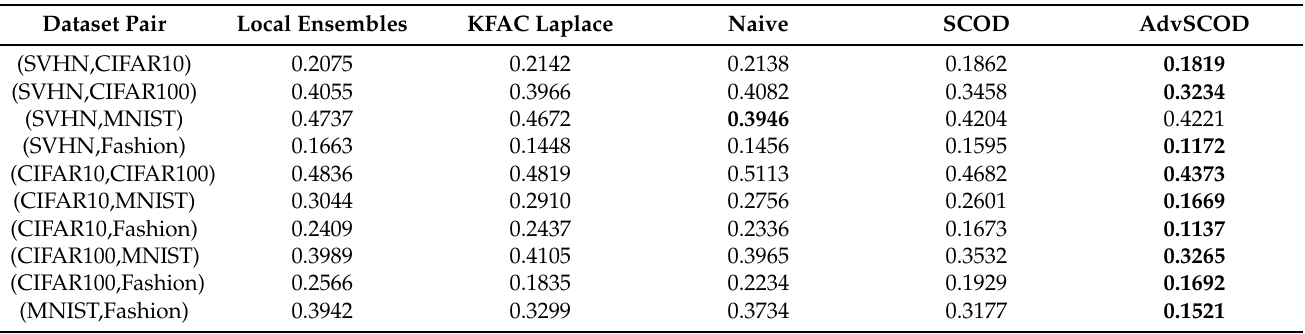
Table 4. Comparison of the OOD detection performance measured by FPR95 avg . Bold numbers